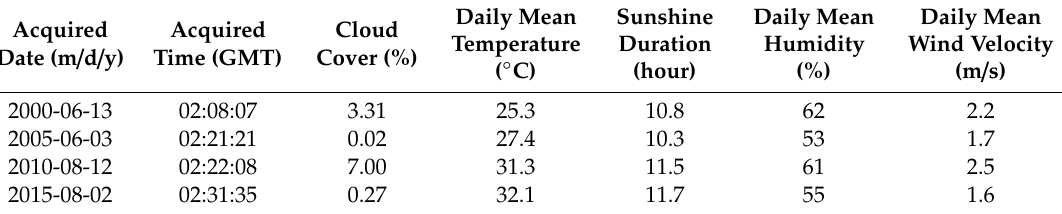
Table 1. List of Landsat images used in this study.